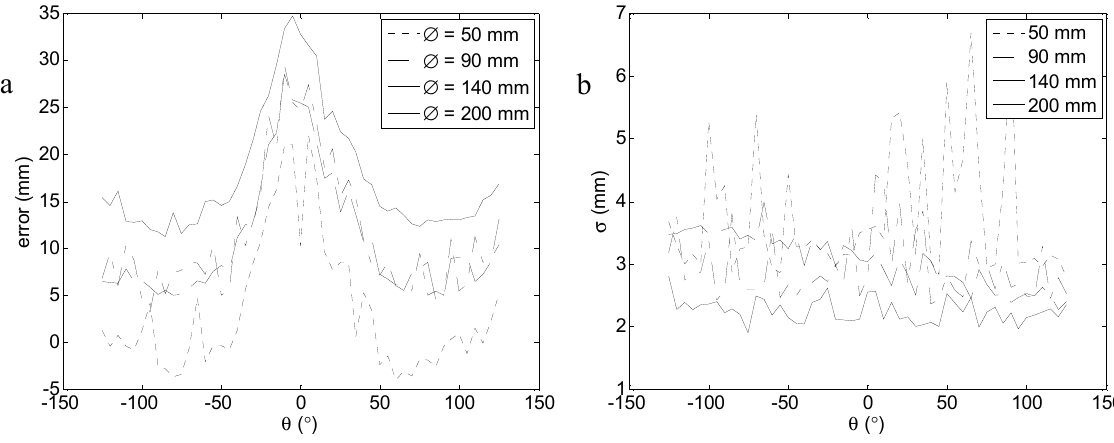
Figure 11. Average error ( a ) and standard deviation ( b ) for different target diameters.